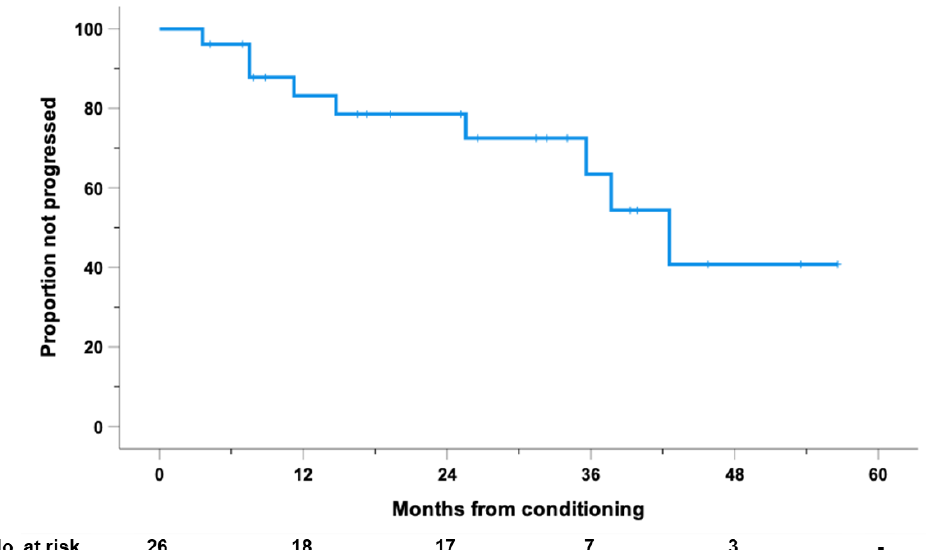
Figure 1. Progression-free survival (PFS), calculated from the day of conditioning, for the entire cohort of 26 high-risk patients with RR-HL who received PD1-blockade after autologous stem cell transplantation (ASCT).